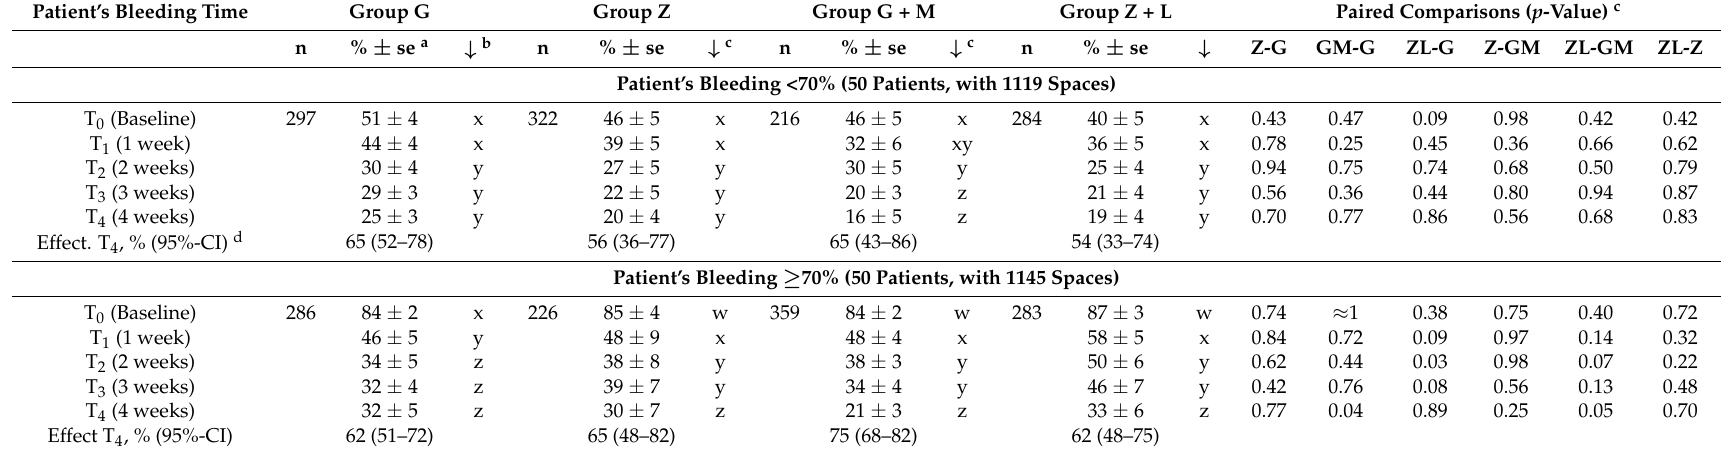
Table 3. Interproximal bleeding after IDB (interdental brush) according to patient’s baseline gingival bleeding and treatment group in 2273 interproximal spaces (from 100